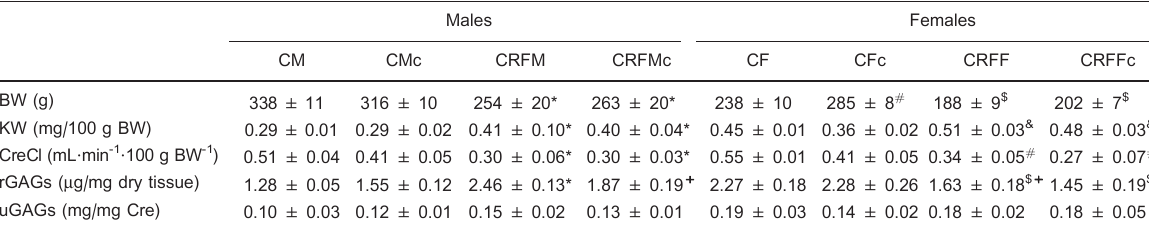
Table 1. Study group data after 30 days.